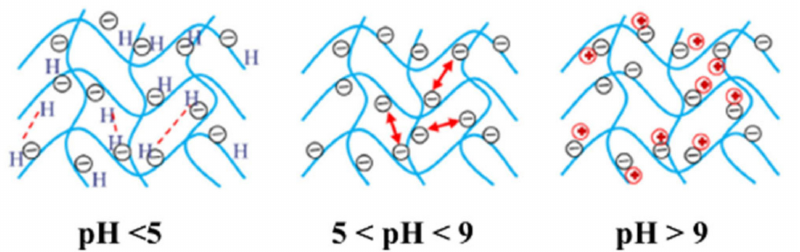
Figure 3. Schematic of the behavior of hydrogel in different pH. Reprinted with permission from [80]. Copyright 2014